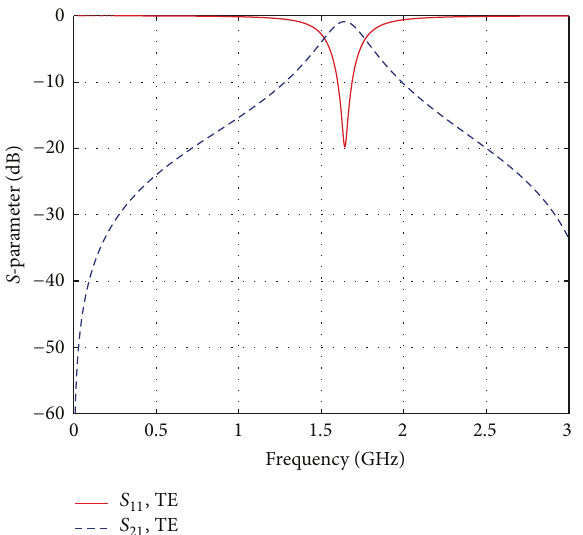
Figure 9: S-parameter characteristics of the designed FSS.